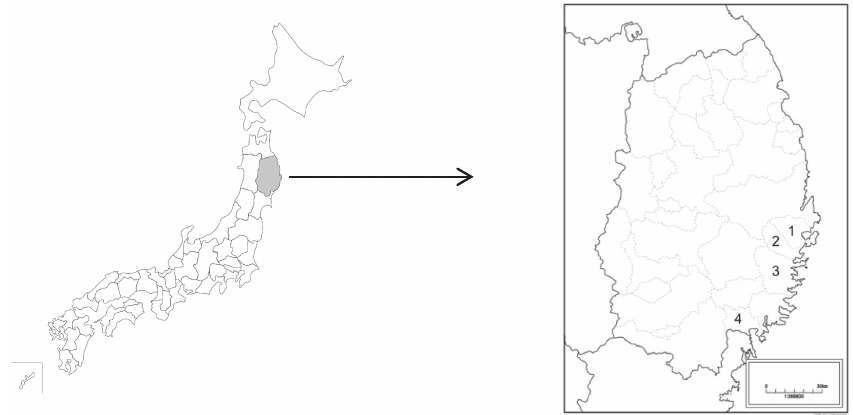
Figure 1. Location of Iwate prefecture, Japan. Damaged areas: 1.Yamada, 2.Otsuchi, 3.Kamaishi, and 4.Rikuzentakata.